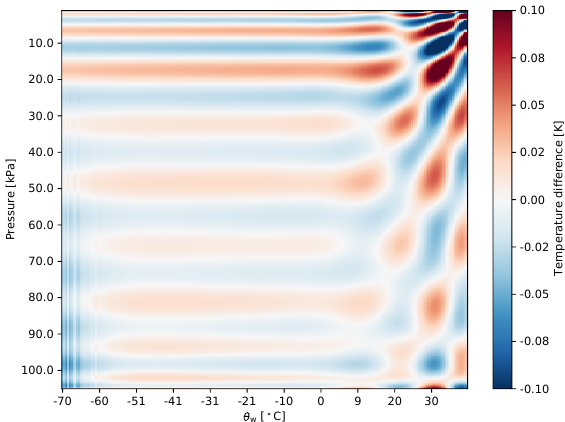
Figure 3. Approximation error between iterated (“truth”) and mod- elled θ w along isotherms T